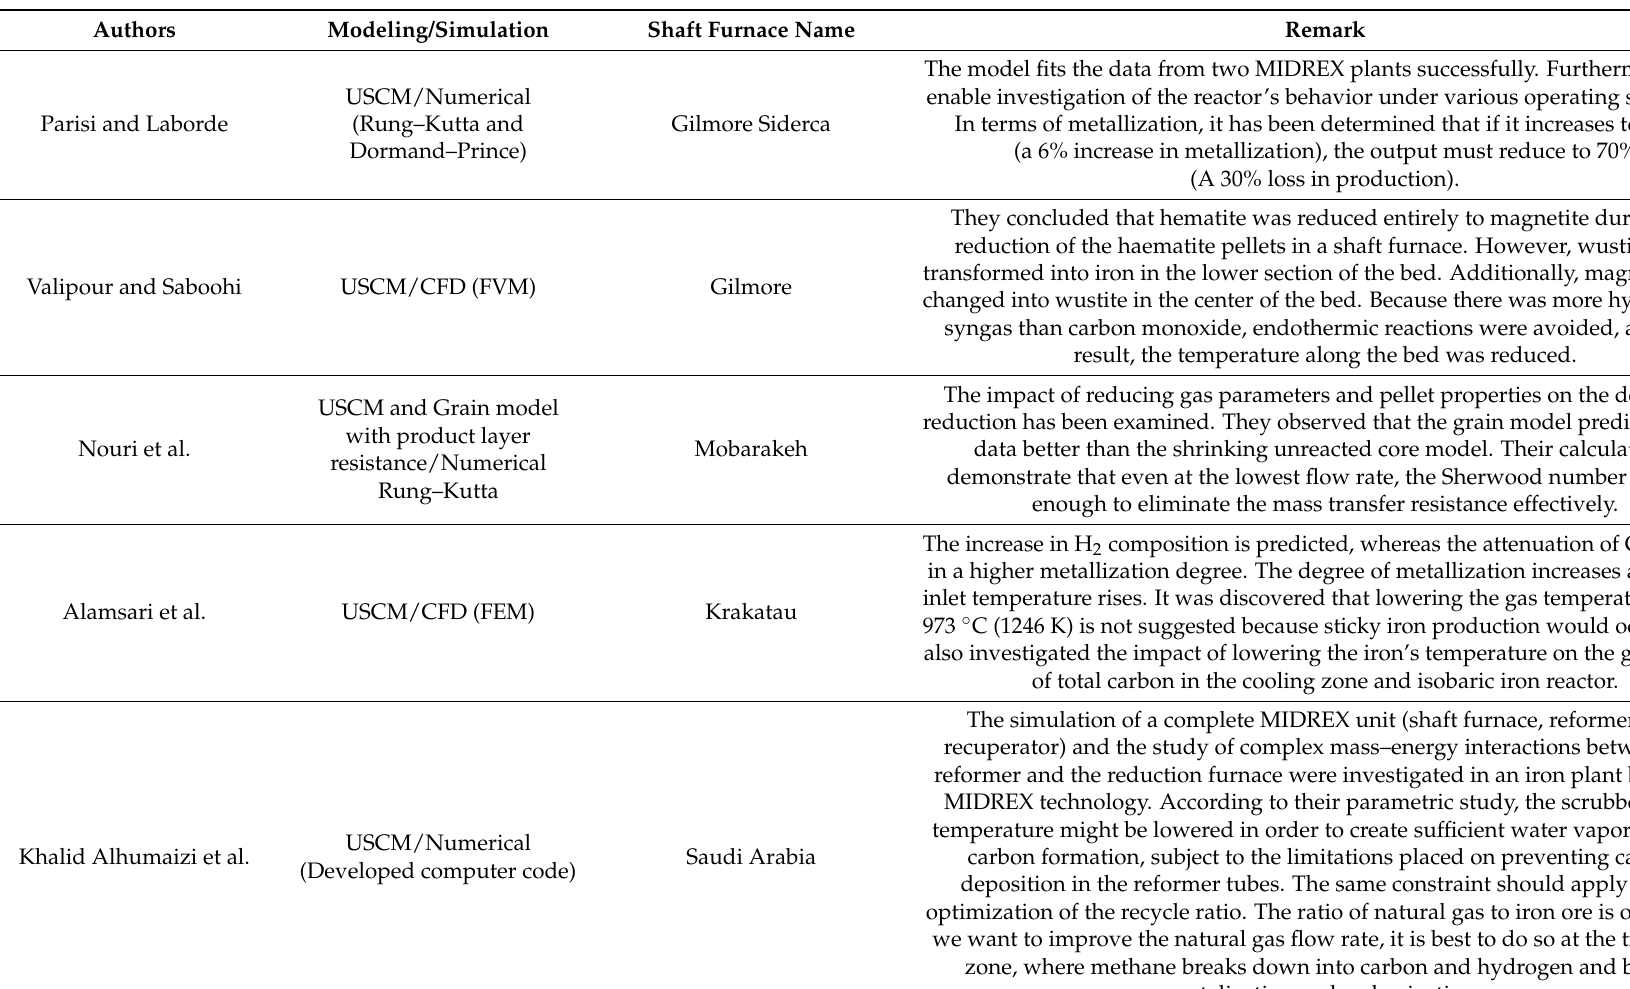
Table 1. Summarized simulation works were validated using industrial